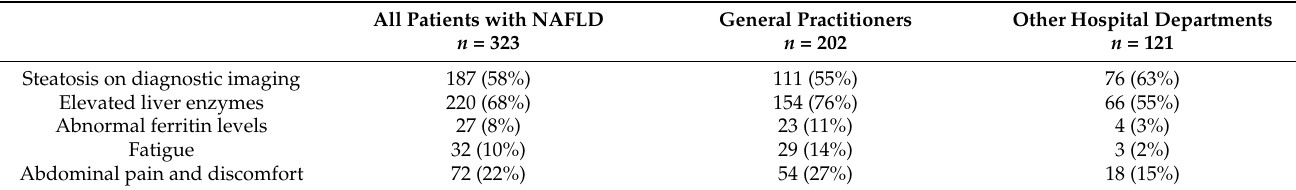
Table 1. Causes of referrals (number and %) and comorbidities described in referral letters of patients with non-alcoholic fatty liver disease (NAFLD). The table shows values for all patients and for patients referred from the primary and secondary sectors. All Patients with NAFLD n =